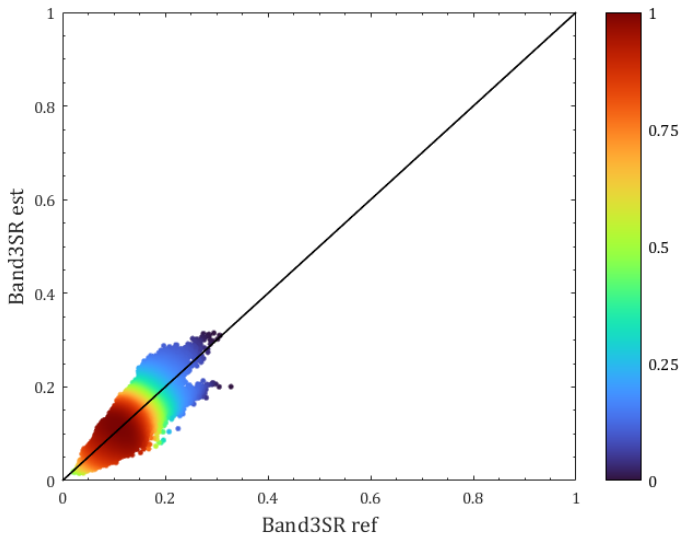
Figure 2. The 3.75 μm band reflectivity scatter density plot for the results of this study compared to the official product